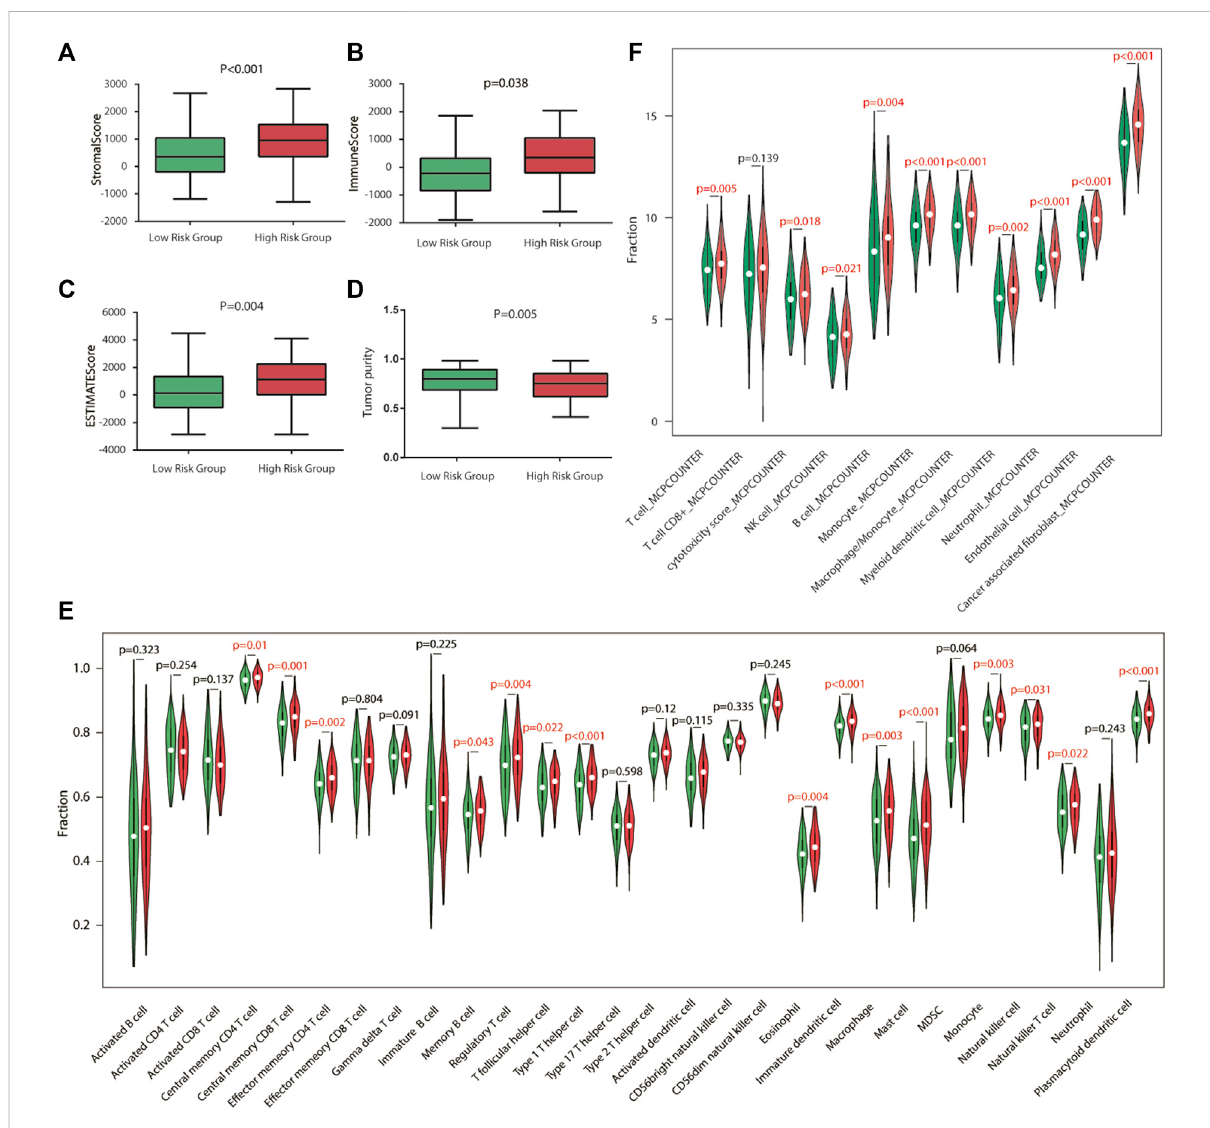
FIGURE 5 Immune characteristics of TCGA cohort. (A – D) Estimation of the proportion of immune-stromal component and tumor purity. Immune score, stromal score, ESTIMATE score (the sum of them), and tumor purity between different risk groups in TCGA cohort. (E) Different in fi ltrating abundances of 28 TIICs estimated by ssGSEA between subgroups. (F) Different in fi ltrating abundances of 11 TIICs estimated by MCP-counter between subgroups. TIICs: tumor-in fi ltrating immune